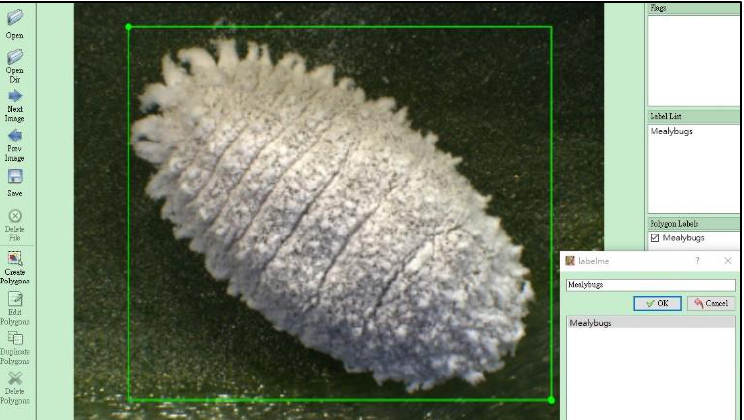
Figure 4. The image annotation tool of labeling.